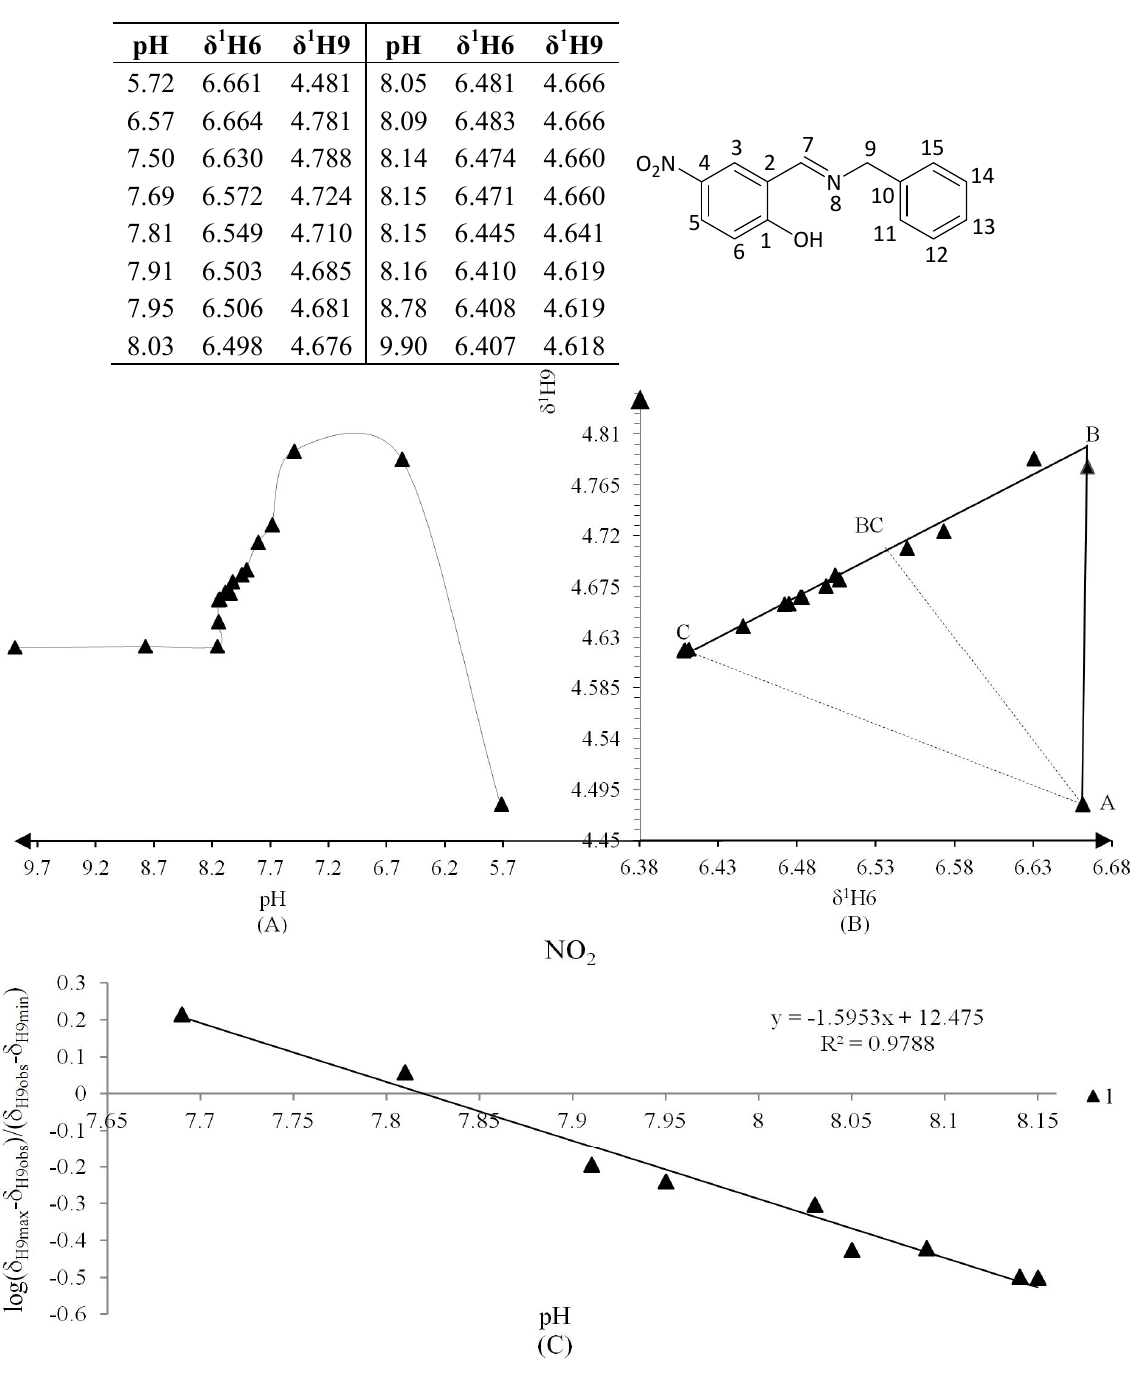
Figure 6. ( A ) titration curve (pH vs. δ 1 H9); ( B ) δ -diagram with Polster-Lachmann analysis ( δ 1 H6 vs. δ 1 H9) and ( C ) plot of the semilogarithmic Henderson-Hasselbalch equation (pH vs. log[( δ − δ )/( δ − δ )]) of compound 1 (R = NO H9max H9obs H9obs H9min